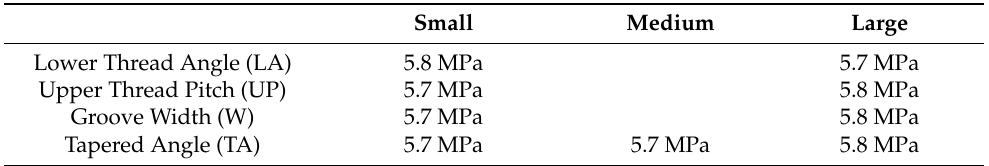
Table 8. Comparison of average stress on the second layer of the reverse buttress part of test block of four different design factors in 20 PCF.